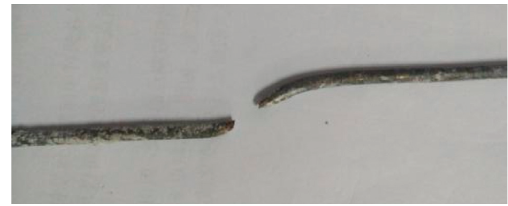
Figure 11: Broken